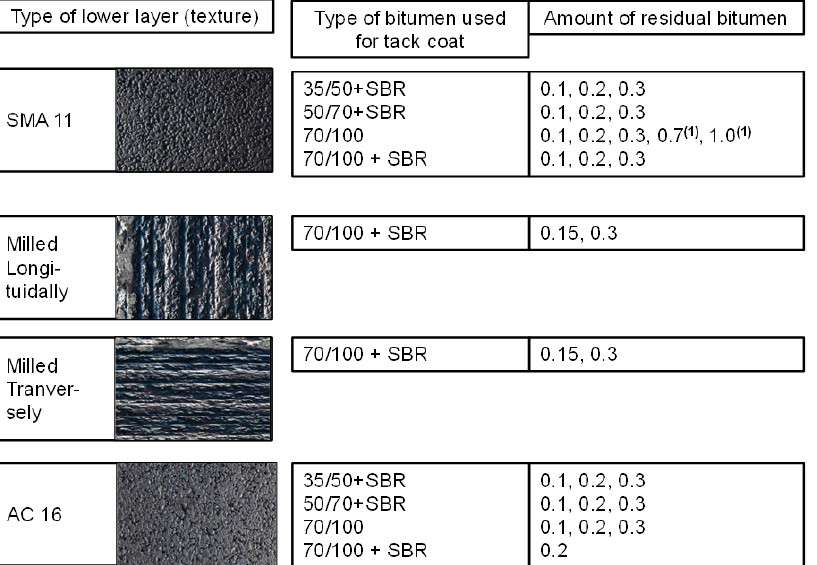
Figure 5. Combinations of bonding techniques used in the project; ( 1) hot bitumen instead of emulsion.